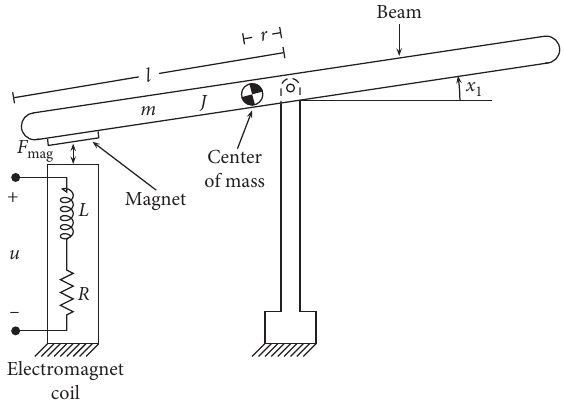
Figure 1: Magnetic levitation